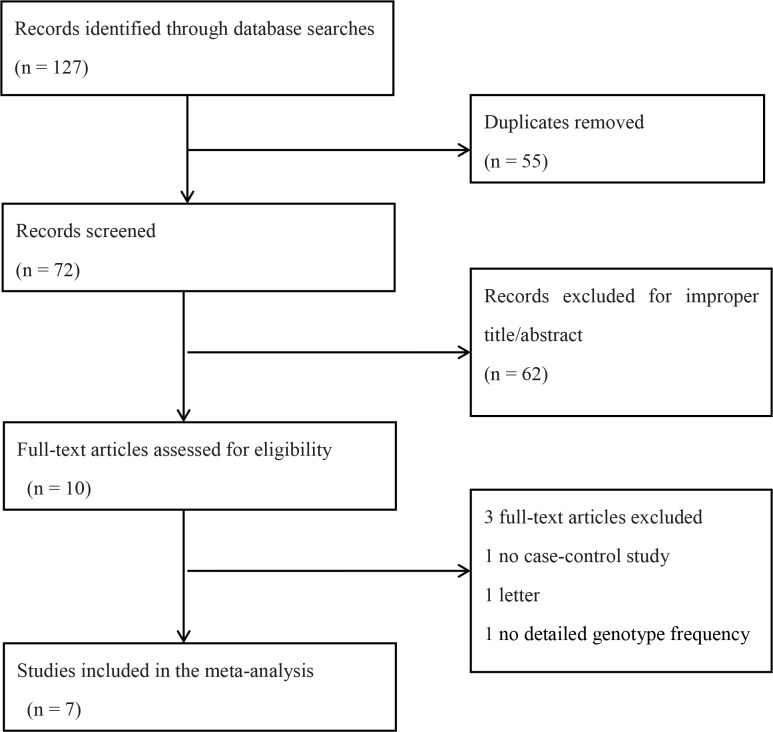
Flow chart of study selection.